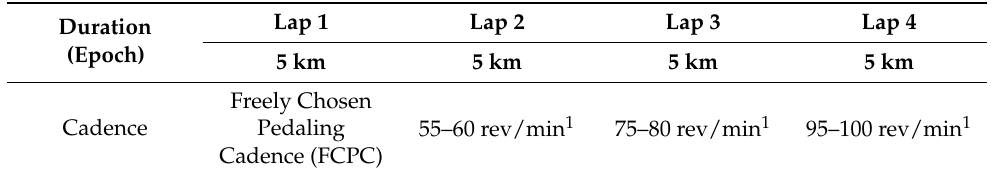
Table 1. Cadence (in rev/min 1 ) protocol performed for experiment 1 and experiment 2. Cadence was fixed (i.e., not randomized) for each